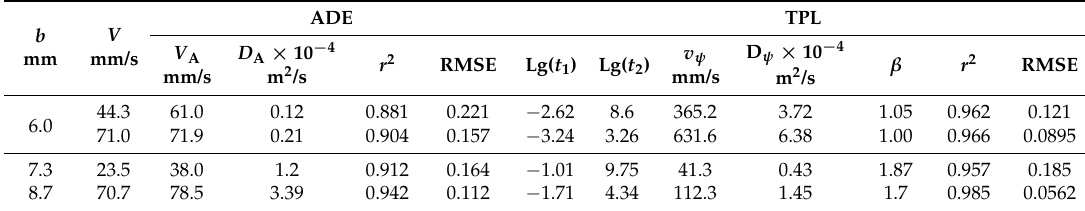
Table 8. Fitting parameters of BTC in single fractures with rectangular rough fractures.